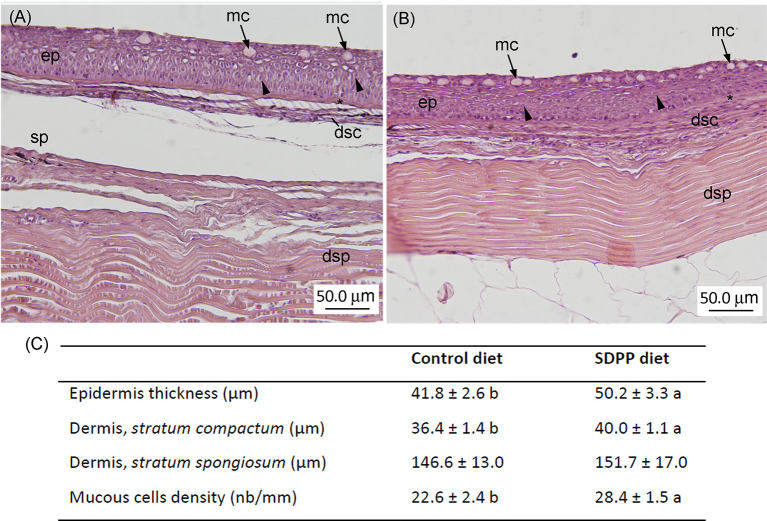
Histological analysis in the skin of gilthead sea bream (Sparus aurata) fed diets containing spray-dried porcine plasma (SDPP). Histological organization of the skin in gilthead seabream (Sparus aurata) fed (A) the control diet and (B) the SDPP supplemented diet. (C) Histological measurements for epidermis thickness, dermis (stratum compactum; stratum spongiosum), and mucous cells density. Different letters within the same row indicate the presence of statistically significant differences between two experimental groups (t-test; P < 0.05). Data are expressed as mean ± standard deviation (n = 4).